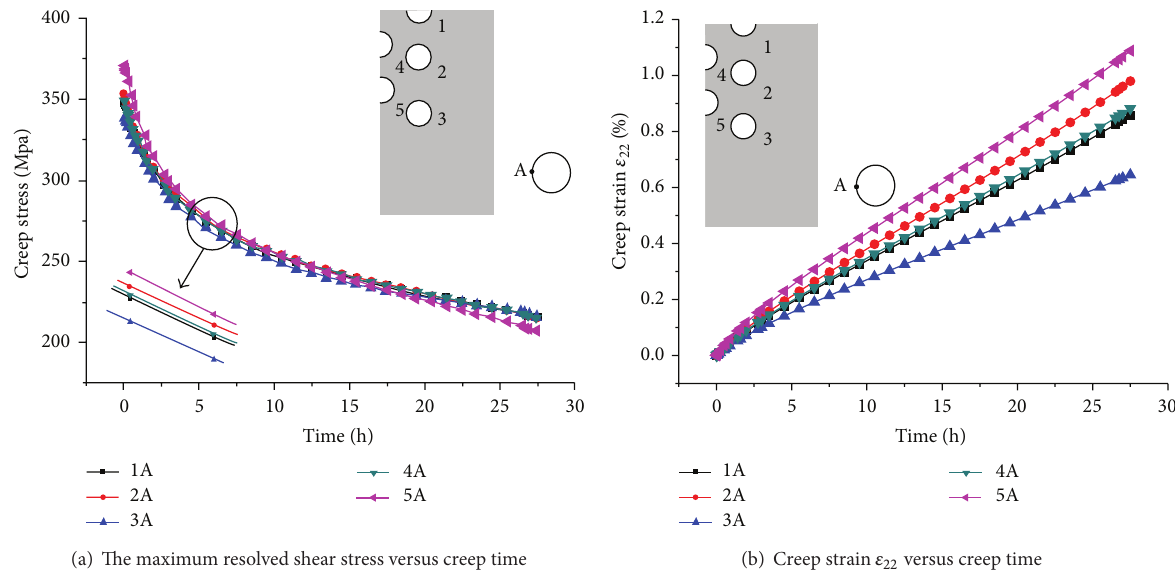
Figure 3: The development of stress at the cooling hole.